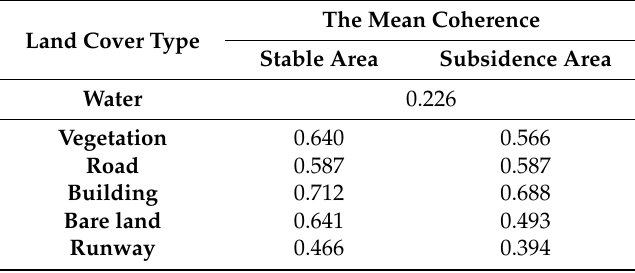
deformation signal. removing